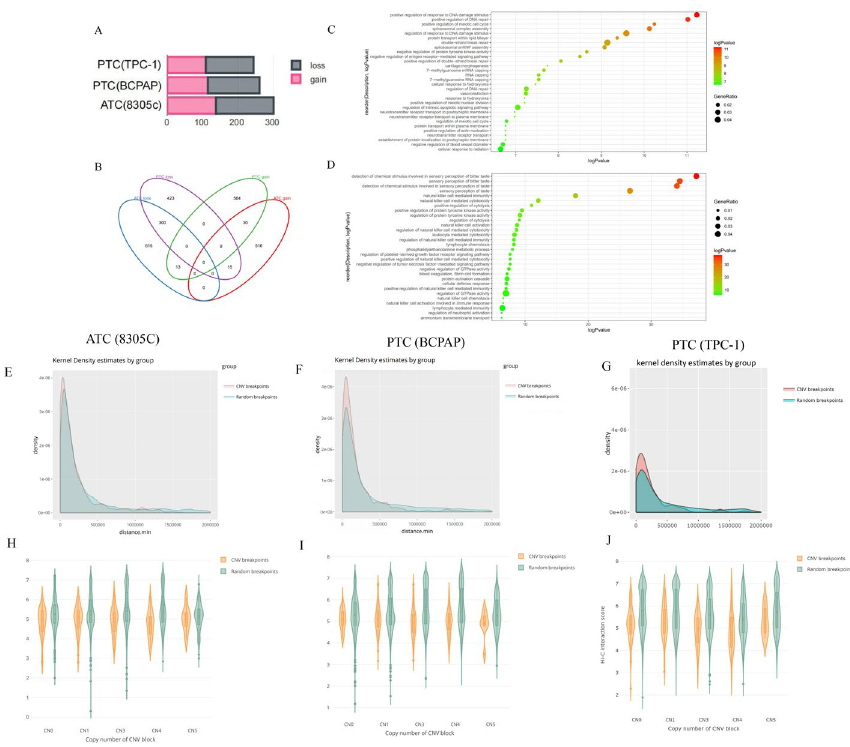
Fig. 3 A – D ATC-specific copy number variations and annotated biological functions. A CNV gain and loss events in ATC (8305C) and both PTC (BCPAP and TPC-1) cell lines; B intersection plot of multiple subgroups of CNV statuses in ATC and both PTC cells; C , D significantly enriched Gene Ontology (biological functions) in genes associated with ATC-specific CNVs gain and loss events. E – J CNV breakpoints associated with TAD boundaries. The distribution plots of the distance between all CNV breakpoints (red line) and random sites (green line) to their nearest TAD boundaries in E ATC (8305C), and F PTC (BCPAP), and G PTC (TPC-1) cells; distributions of distances (kb) from various CNV events to the nearest TAD boundaries in H ATC (8305C), I PTC (BCPAP), and J PTC (TPC-1)